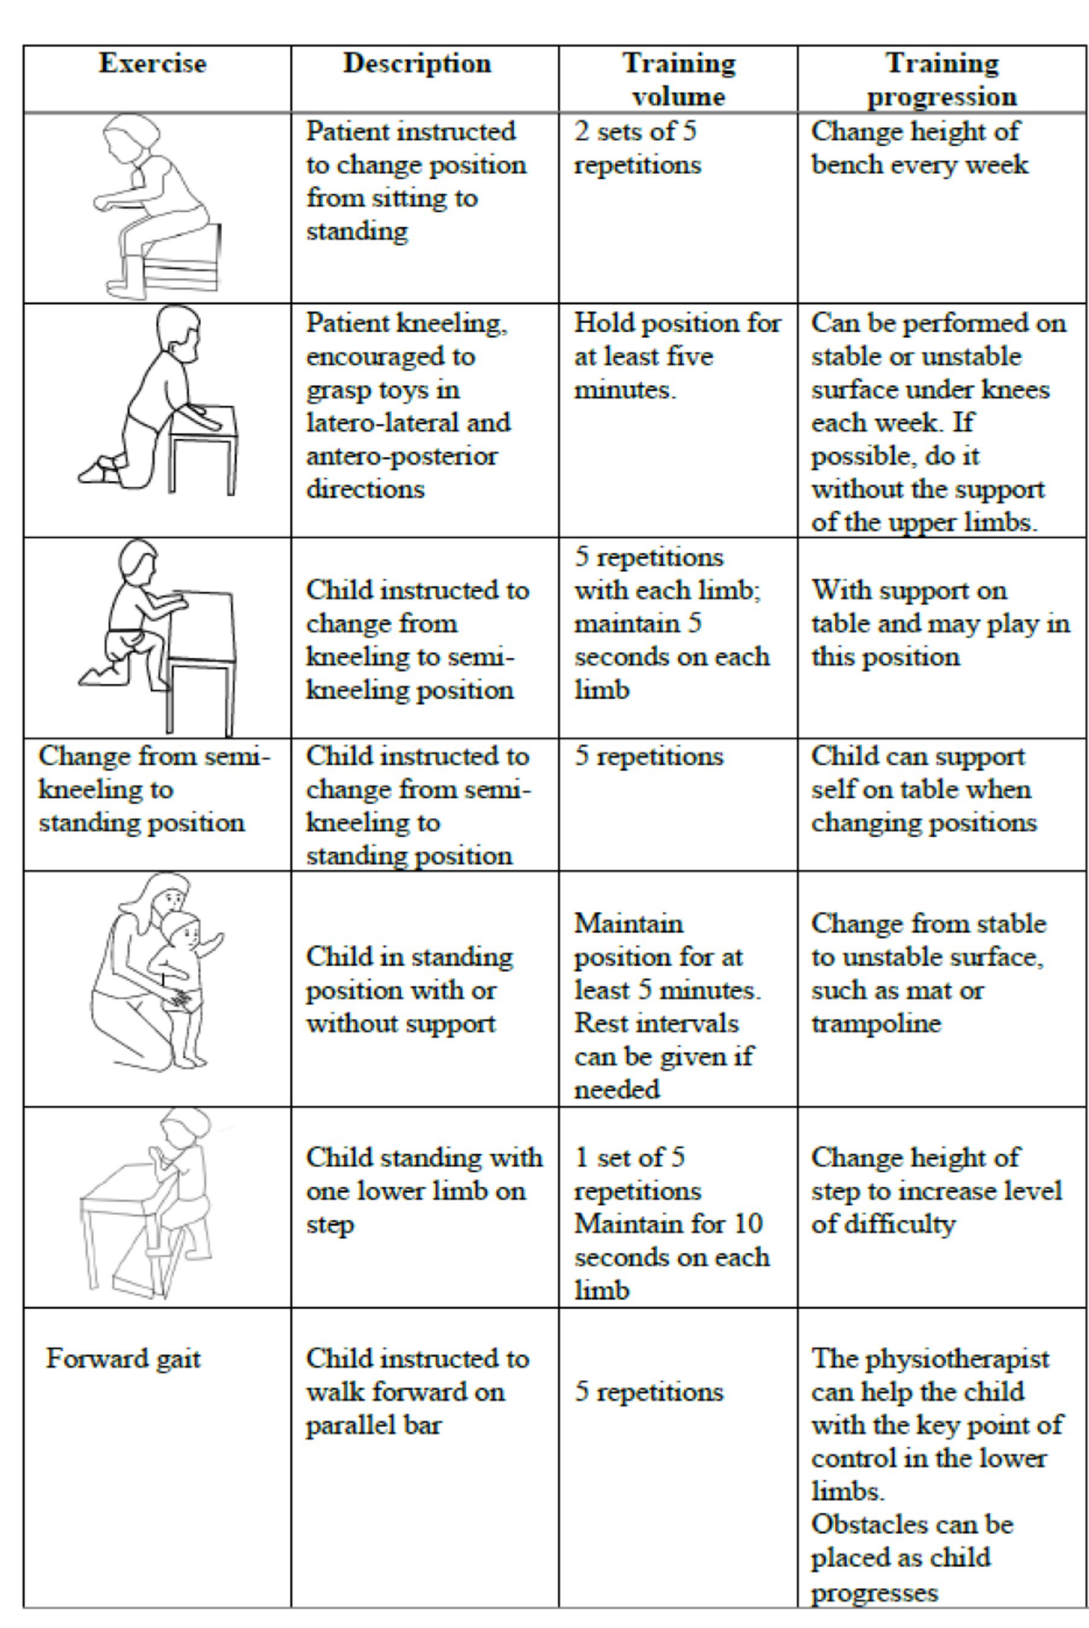
Fig 2. Functional